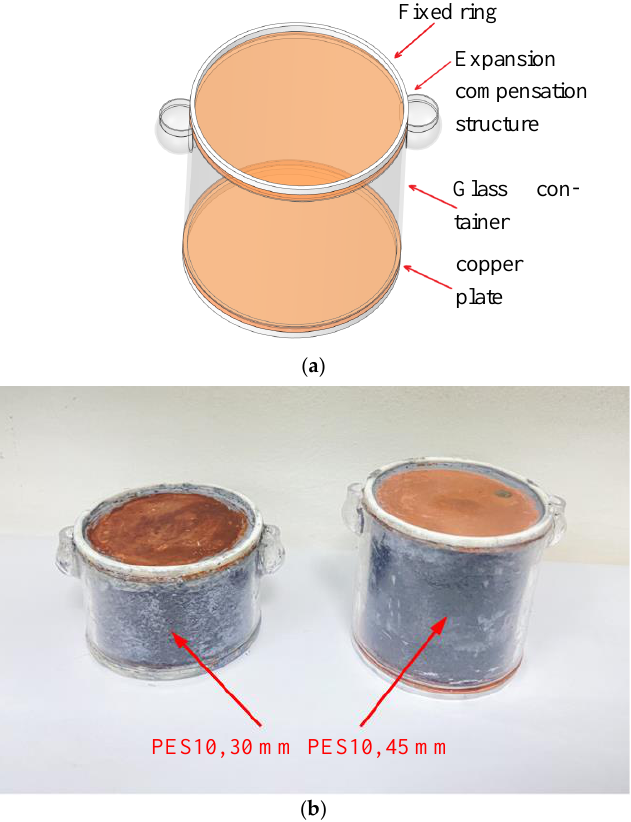
Figure 3. Schematic diagram of the sample containers in the liquid state. ( a ) Glass container and ( b ) layout of samples.